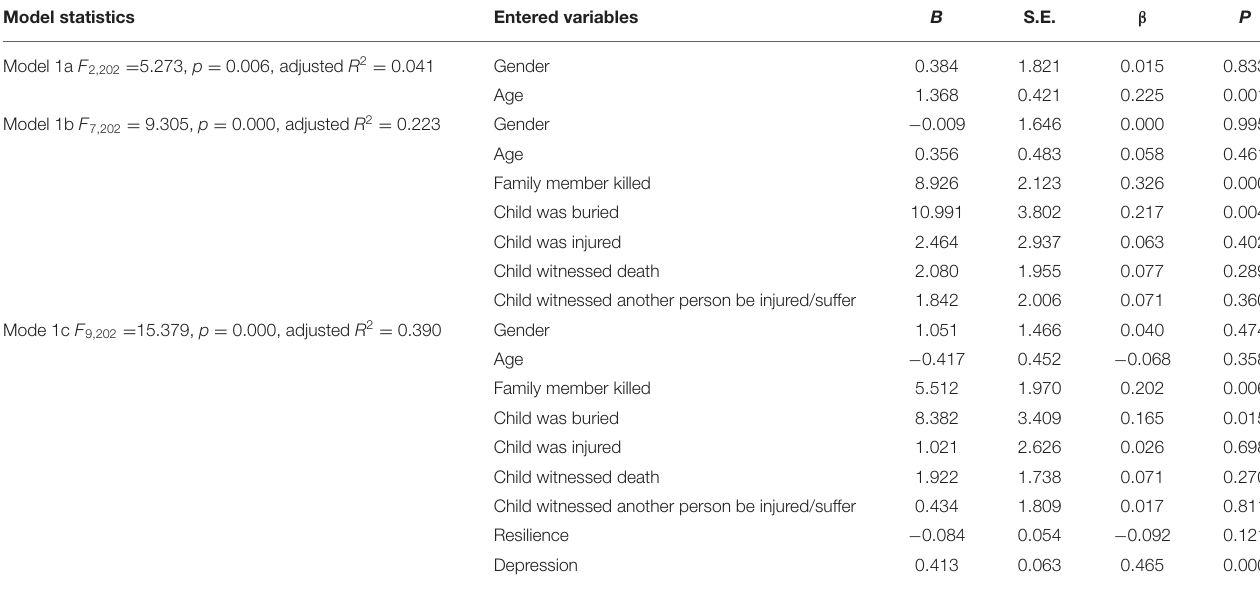
TABLE 2 | Predictors of PTSD severity at study entry. Model statistics Entered variables B S.E.